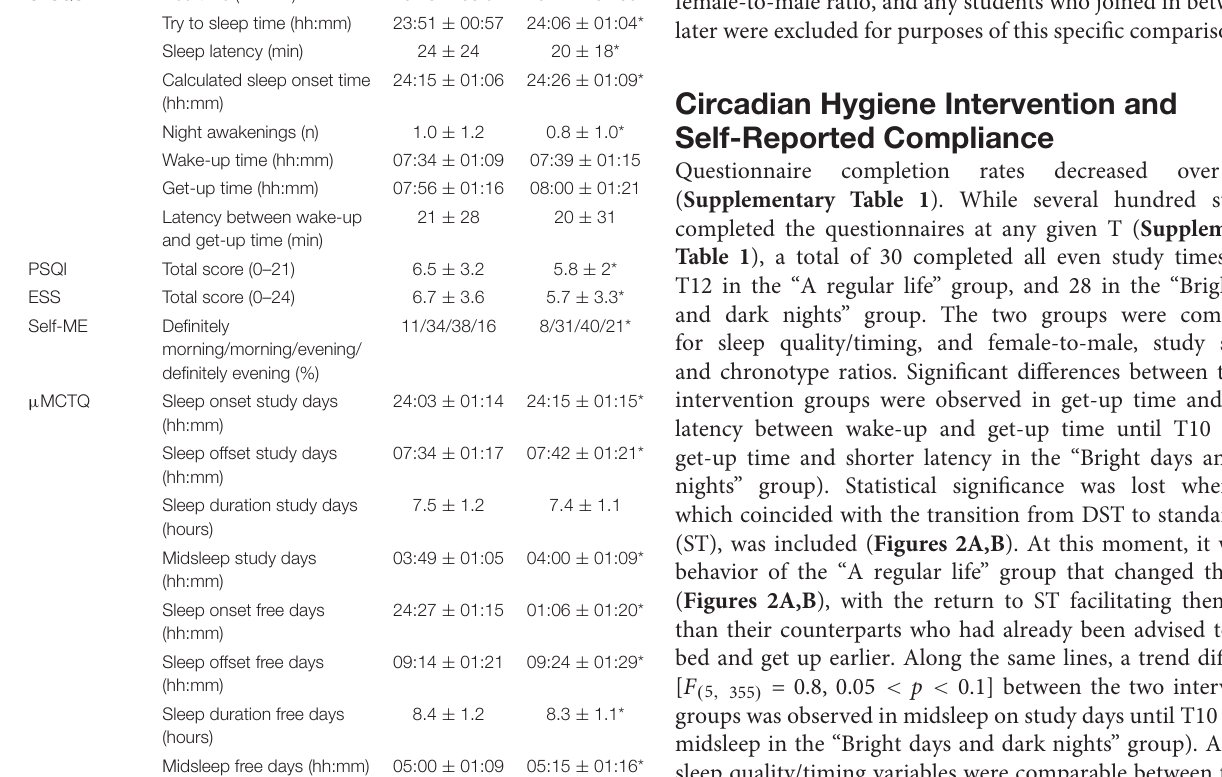
TABLE 1 | Sleep–wake indices (mean ± SD) on joining the initiative at T0, by sex. Questionnaire Variable Females ( n =